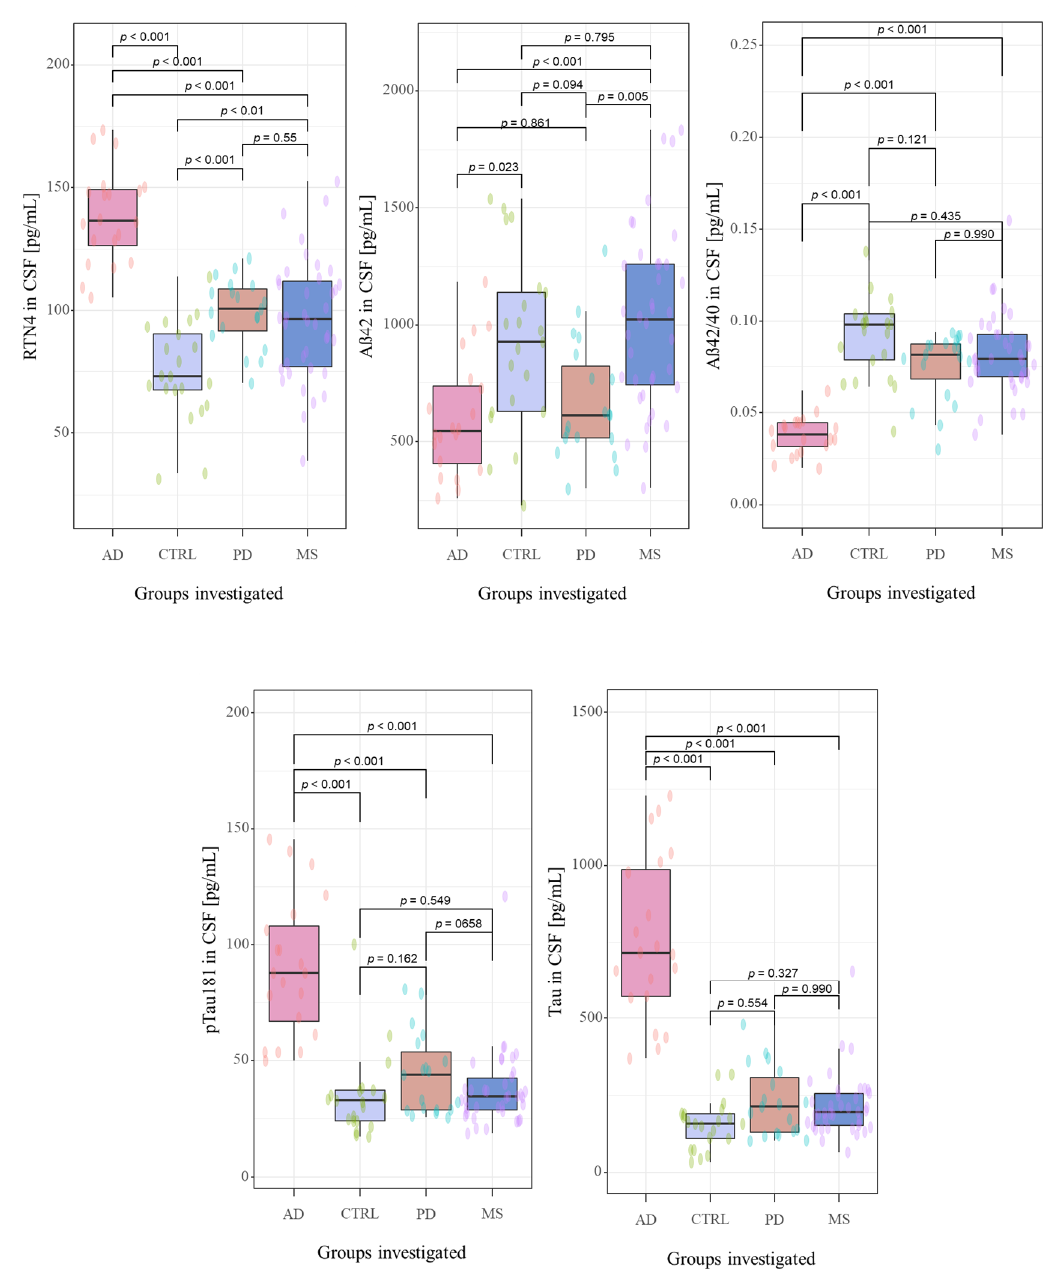
Figure 2. The distribution the CSF concentrations of tested biomarkers in examined groups. Abbreviations: Cerebrospinal fluid (CSF), Reticulon 4 (RTN4), Alzheimer’s disease (AD), Parkinson disease (PD), Multiple sclerosis (MS), Control group (CTRL).